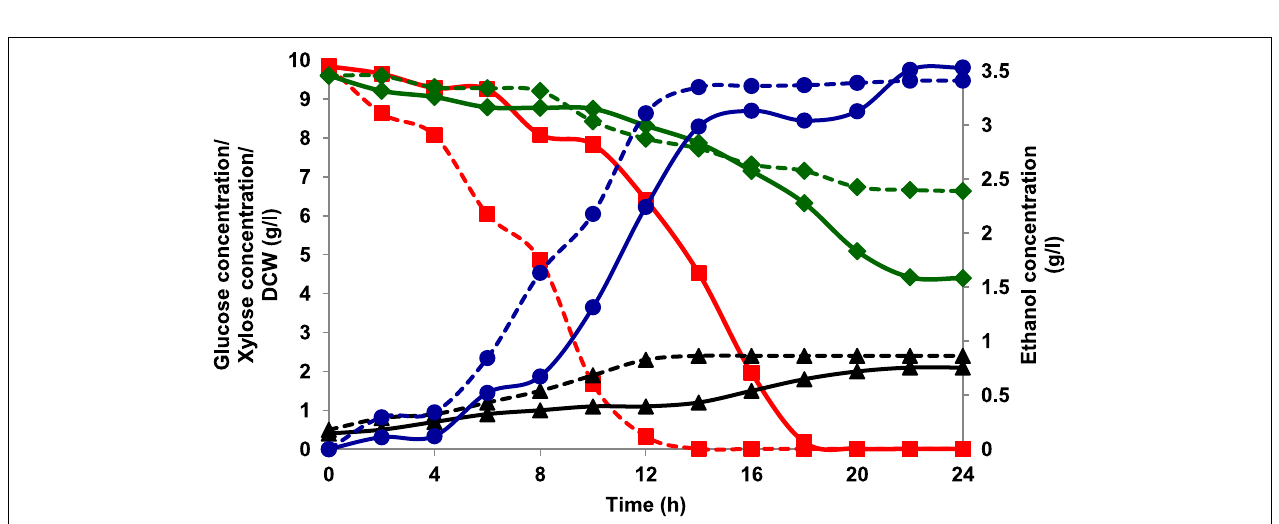
FIGURE 3 | Growth of K. marxianus NIRE-K1 and NIRE-K3 in YEPDX medium, (---) K. marxianus NIRE-K1; (—) K. marxianus NIRE-K3; ( (cid:4) ) Glucose; ( (cid:7) ) Xylose; ( N ) Dry cell weight (DCW); ( • ) Ethanol.